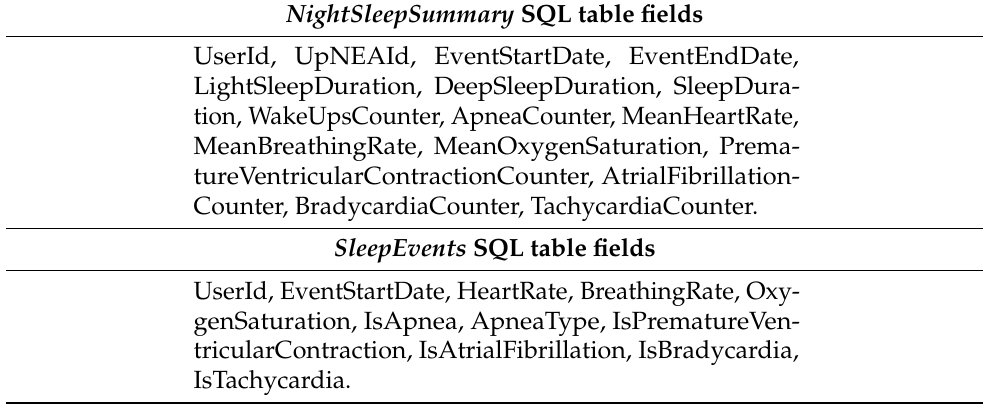
Table 4. SQL tables data